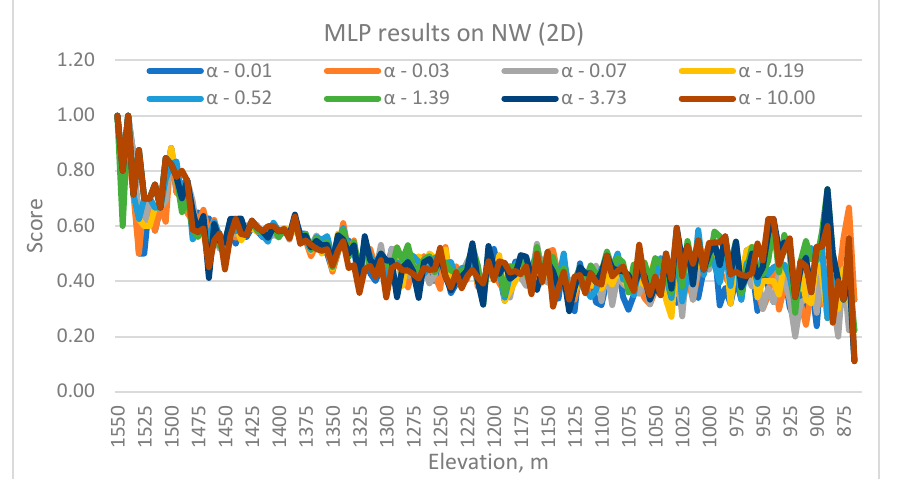
Figure 1. Variation in MLP prediction performance with elevation and α in NW.